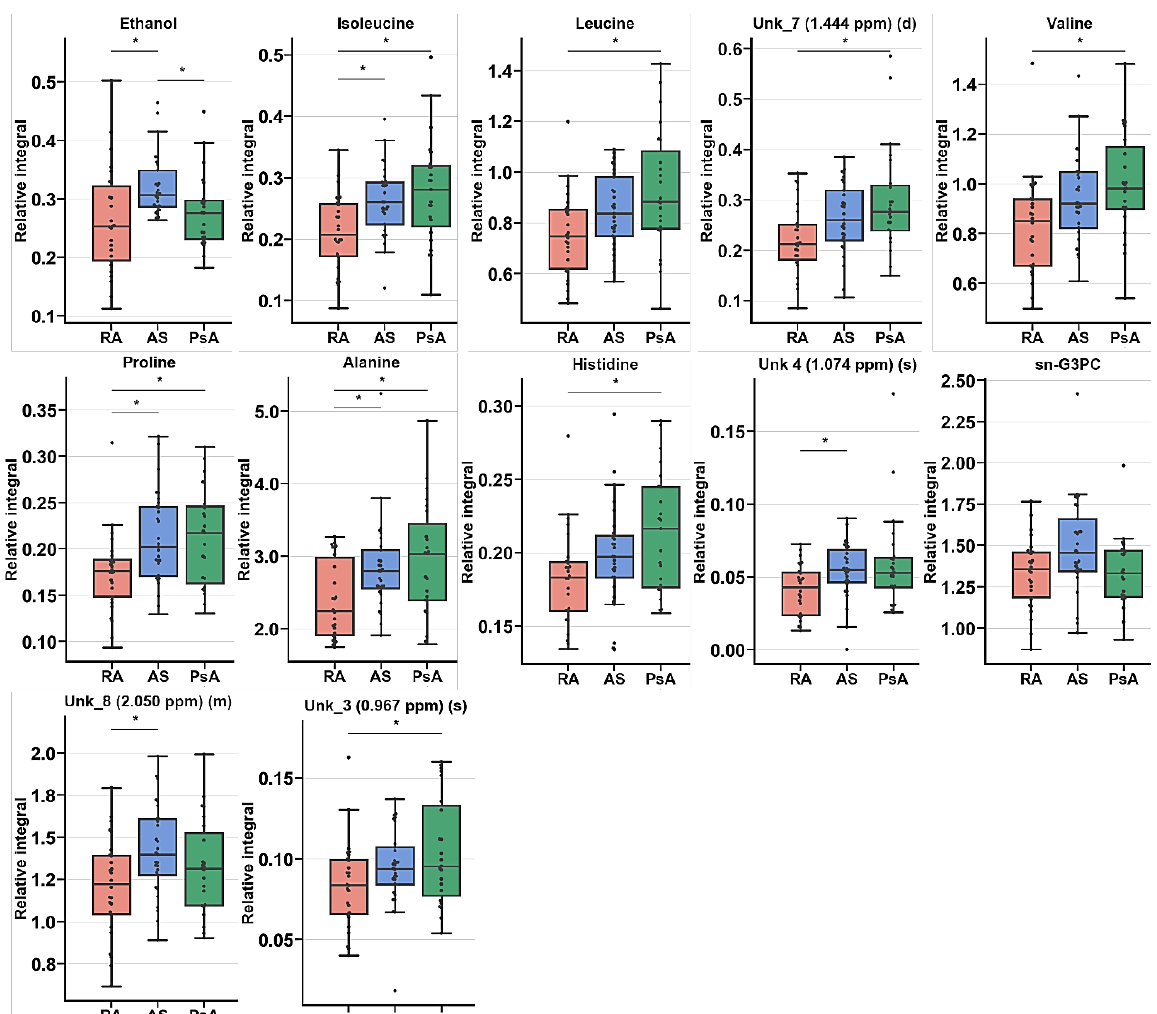
Figure 7. Boxplot for statistically important metabolites in ANOVA or Kruskal – Wallis test Figure 1; 5 × interquartile range (IQR); bar — average; box — range between first quartile (Q1) and third quartile (Q3). * Metabolites important in Tukey’s HSD or Dunn – Sidak test.